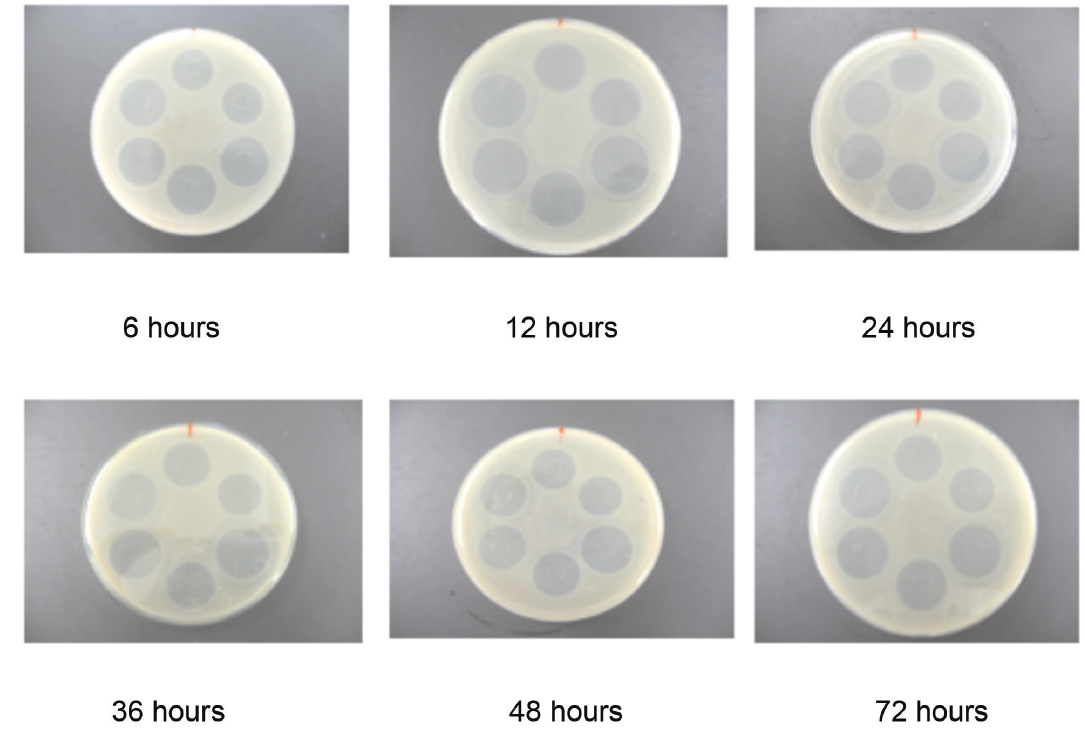
FIGURE 7 - Zone diameters for the azithromycin under UV germicide light (254 nm)